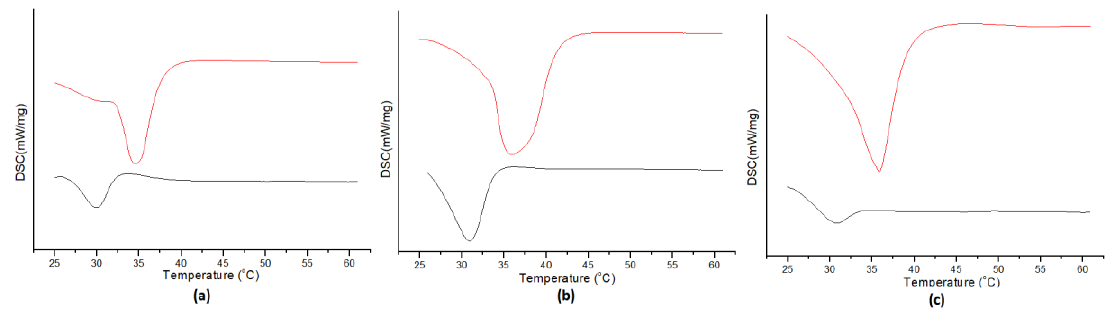
Figure 6. DSC diagrams: ( a ) milk chocolate, ( b ) dark chocolate, ( c ) white chocolate (black lines) and their drug-loaded formulations (red lines).